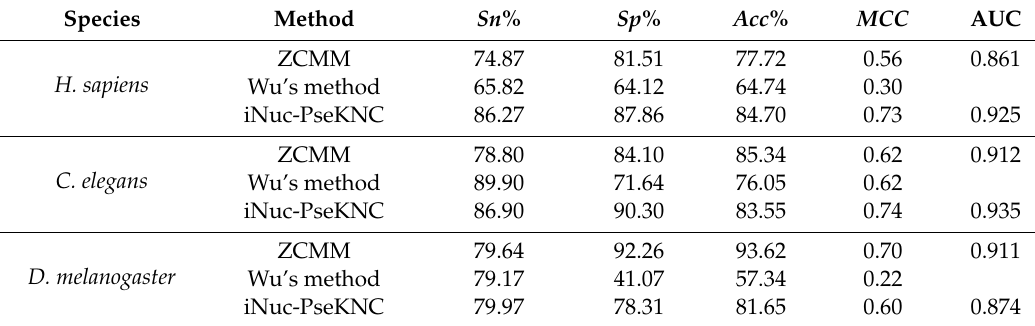
Table 3. Performance compared with other methods.